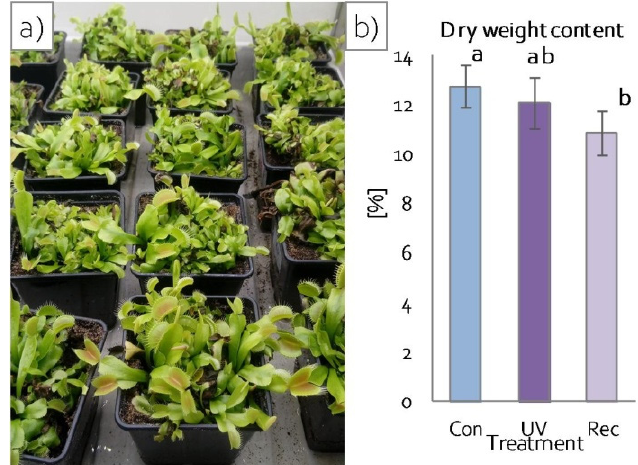
Figure 2. Growth of D. muscipula plants under UV-A treatment: ( a ) plant morphology; ( b ) dry weight content; Con—control plants; UV—UV plants; Rec—recovery plants; different letters—statistically significant differences at p ≤ 0.05; n = 5.